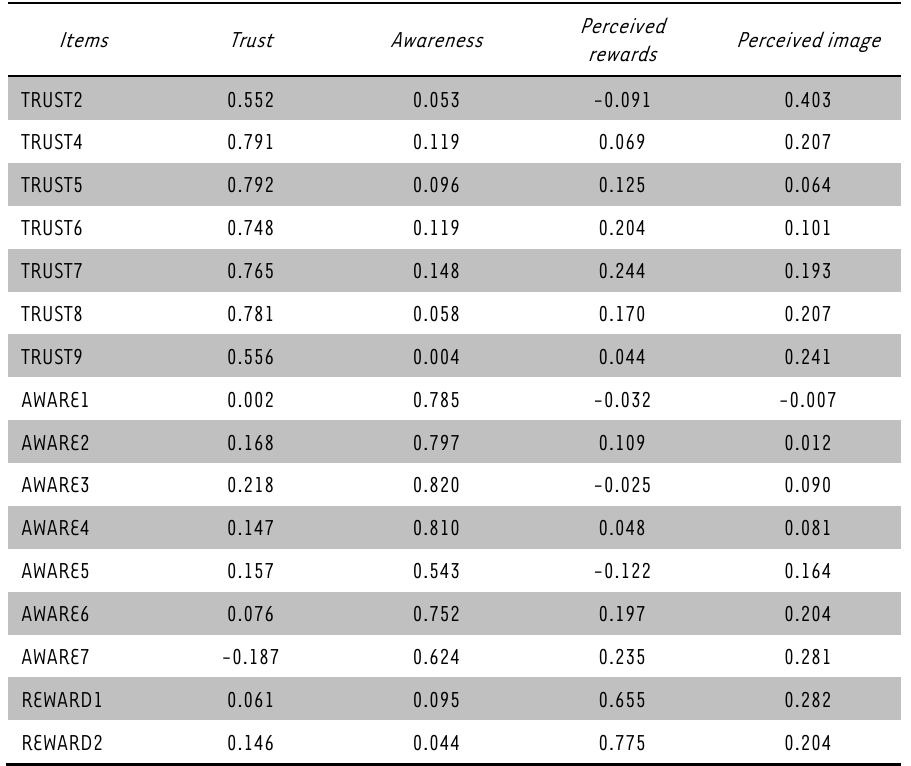
TABLE 1: Factor structure – independent